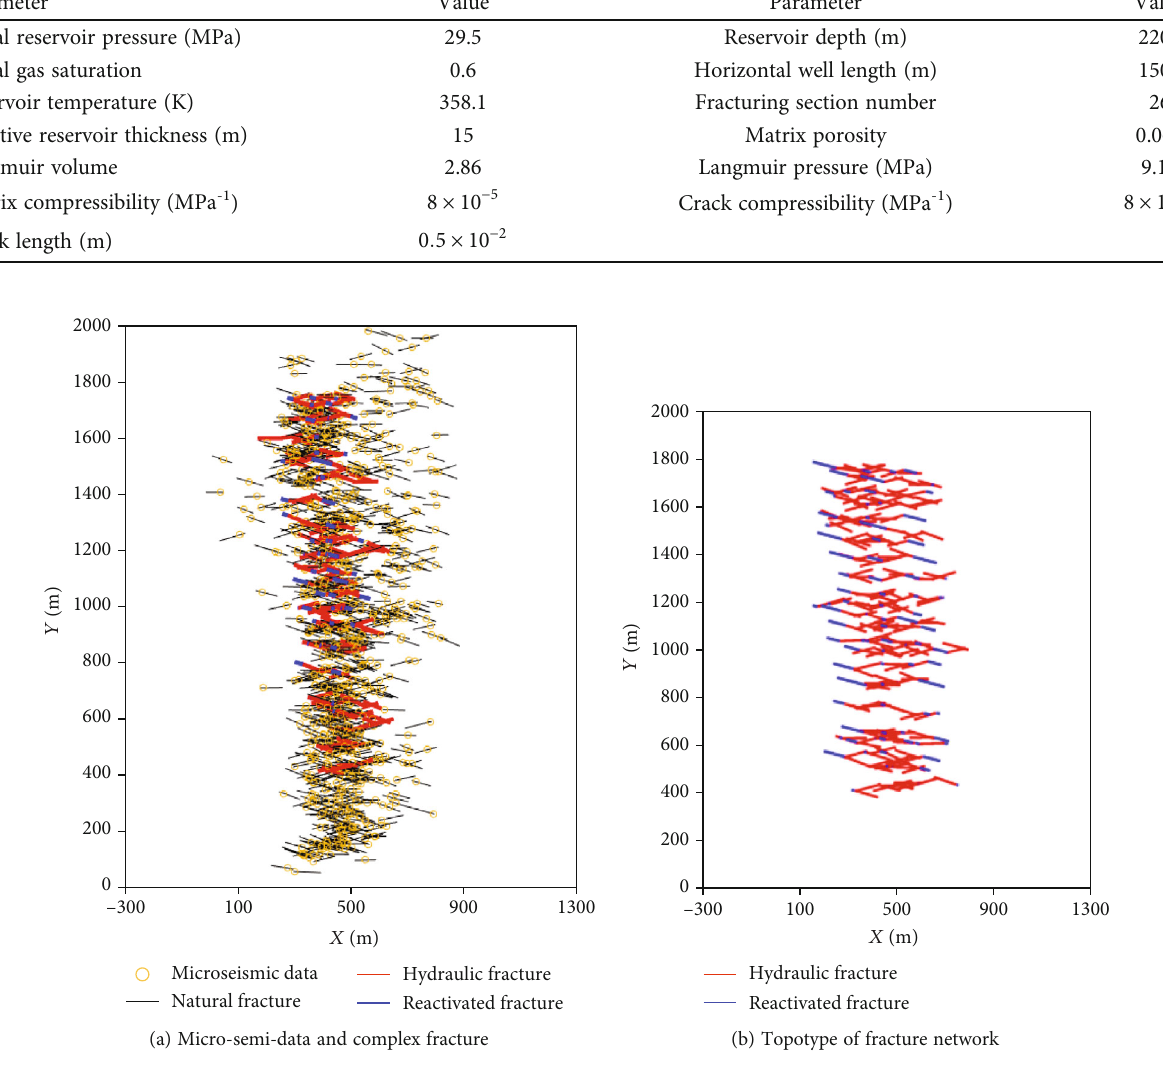
Figure 5: Complex fracture networks reconstruction